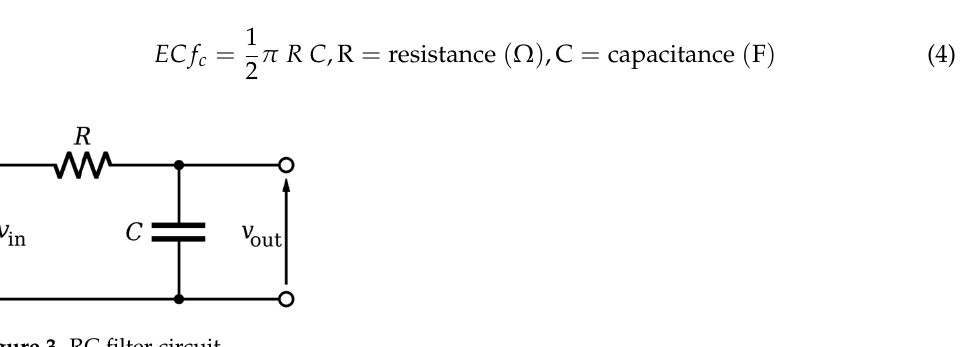
Figure 2. ( a ) TreeTalker platform based on ATMEGA 328 P 8-bit processor AVR RISC 8 MHz, ( b ) Heater probe, 0.2 watts, ( c ) Ref probes including a capacitance sensor and a thermistor, front and back, respectively, and ( d ) installation tool for the Ref probe.